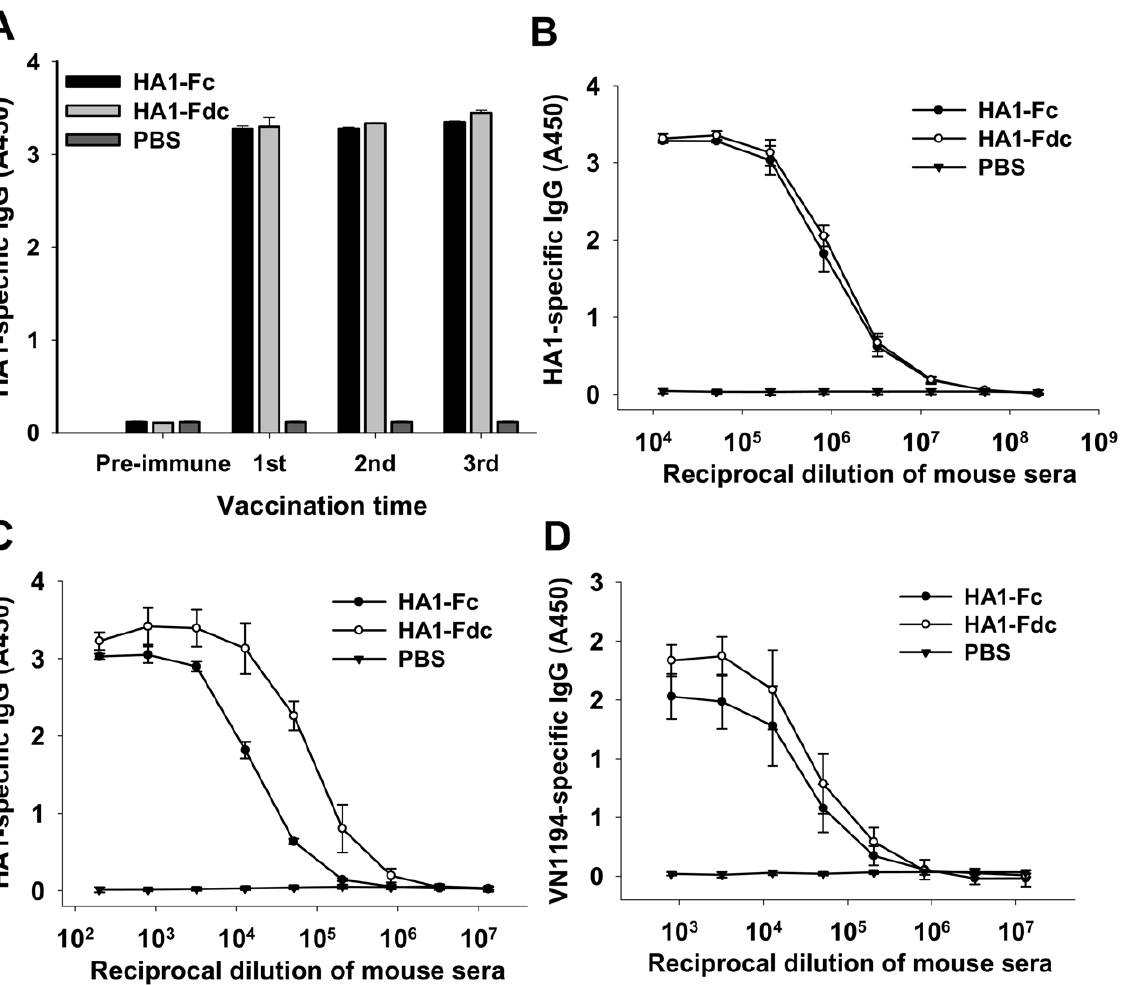
Figure 3. Detection of total IgG antibody responses by ELISA in HA1-Fc- and HA1-Fdc-vaccinated mouse sera. PBS was used as the negative control. (A) Reactivity of IgG antibody with HA1-Fc and HA1-Fdc proteins. The HA1-specific IgG was detected using sera (1:3,000) from mice before (pre-immune) and 10 days after each vaccination. The data are presented as mean A450 6 standard deviation (SD) of five mice per group. Ability of IgG binding to HA1-Fc and HA1-Fdc proteins (B), HA1 protein without Fd and Fc (C), and VN/1194 inactivated H5N1 virus (D), respectively, was detected using mouse sera from 10 days post-last vaccination. The data are presented as mean A450 6 SD of five mice per group at various dilution